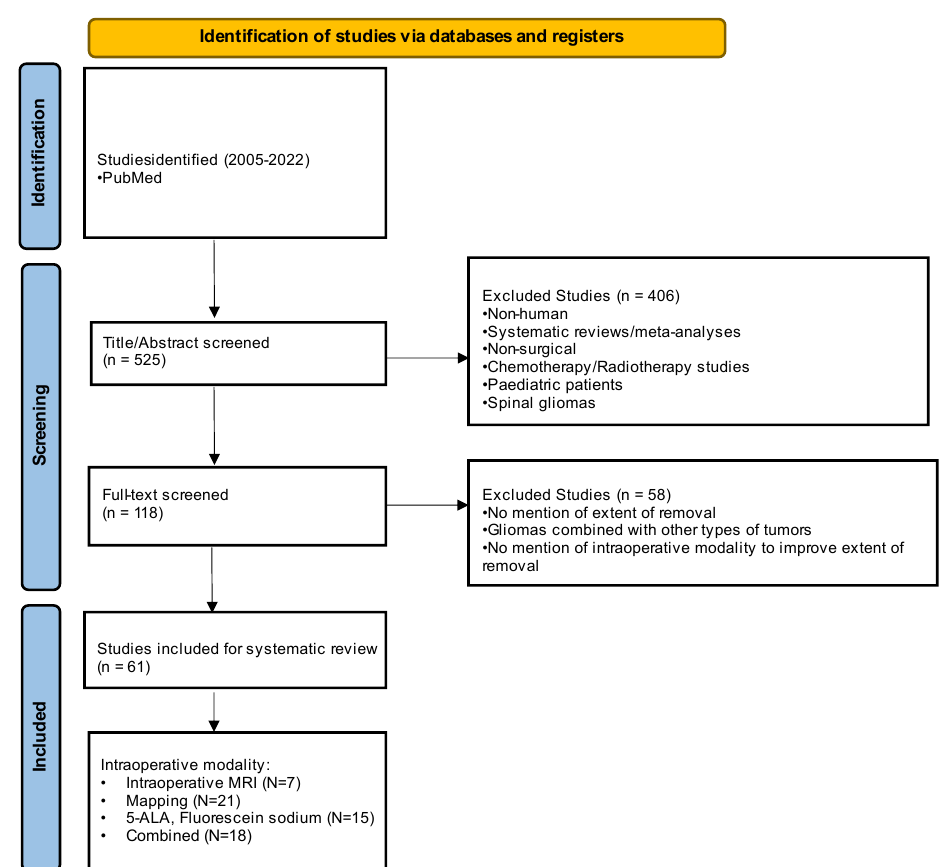
Figure 1. PRISMA flow of the systematic